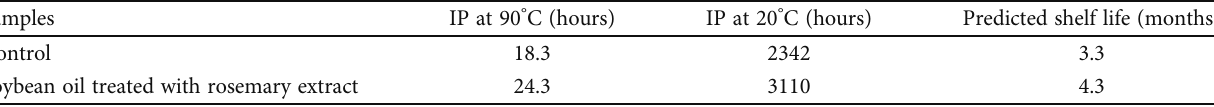
Table 1: Induction period and predicted shelf life of the samples analyzed in OXIPRES.